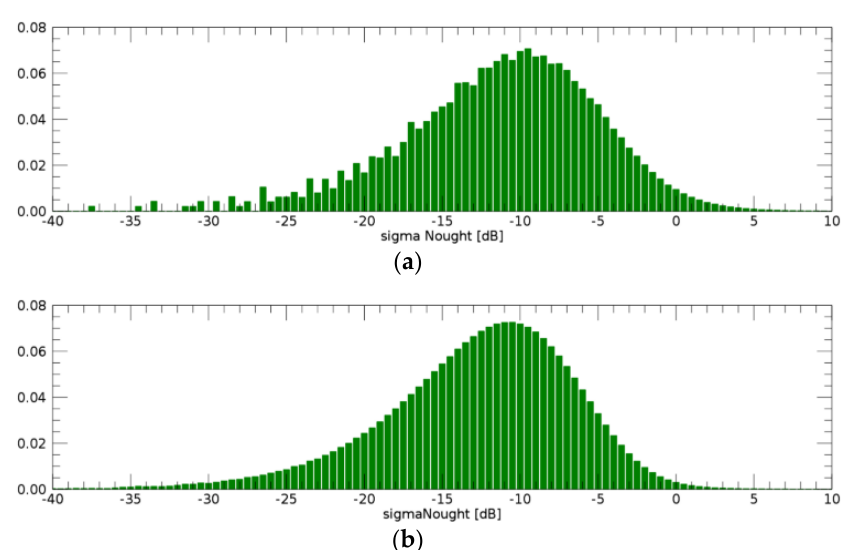
Figure 12. Distribution of the backscattering coefficient σ 0 (dB): ( a ) obtained without compensation of topography-induced radiometric distortions; ( b ) obtained by including the compensation of topography-induced radiometric distortions.